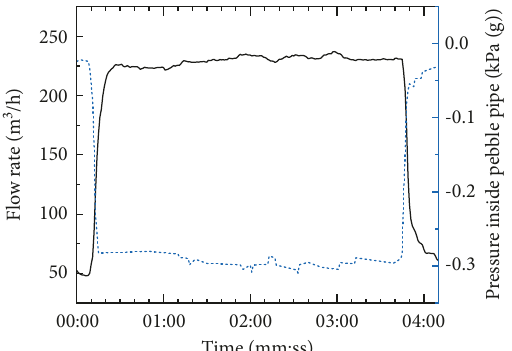
Figure 5: Flow rate and pressure inside pebble conveying pipe versus time during air blowing by the Roots blower.